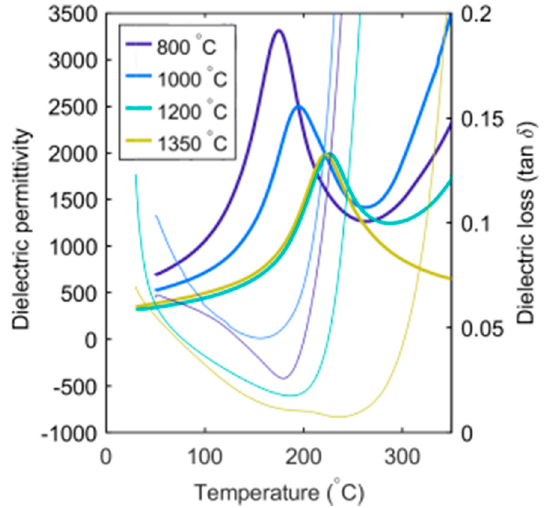
Figure 1. Dielectric permittivity (thick lines) and loss (thin lines) of SBN33 quenched from four different heat treatment temperatures at 1000 Hz. Note that the samples heat treated at 1200 and 1350 °C have been reoxidized.